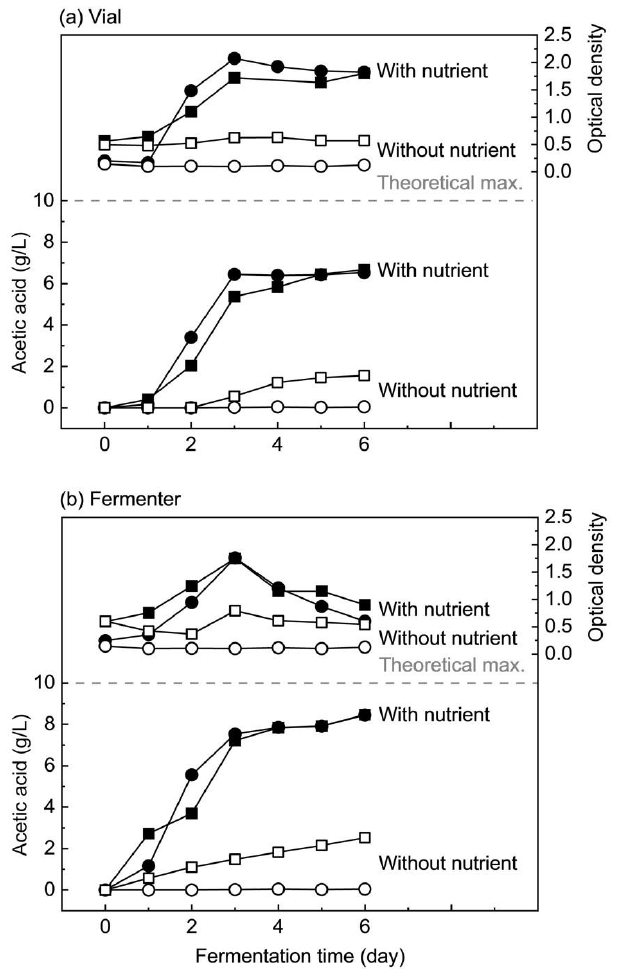
Figure 2. Comparison of acetic acid production and cell growth during fermentation in ( a ) vials and ( b ) fermenters of hydrolyzed nipa sap (square) and 1:1 mixture of glucose and fructose (circle) by M. thermoacetica ; filled symbols: with full nutrient, open symbols: without nutrient.